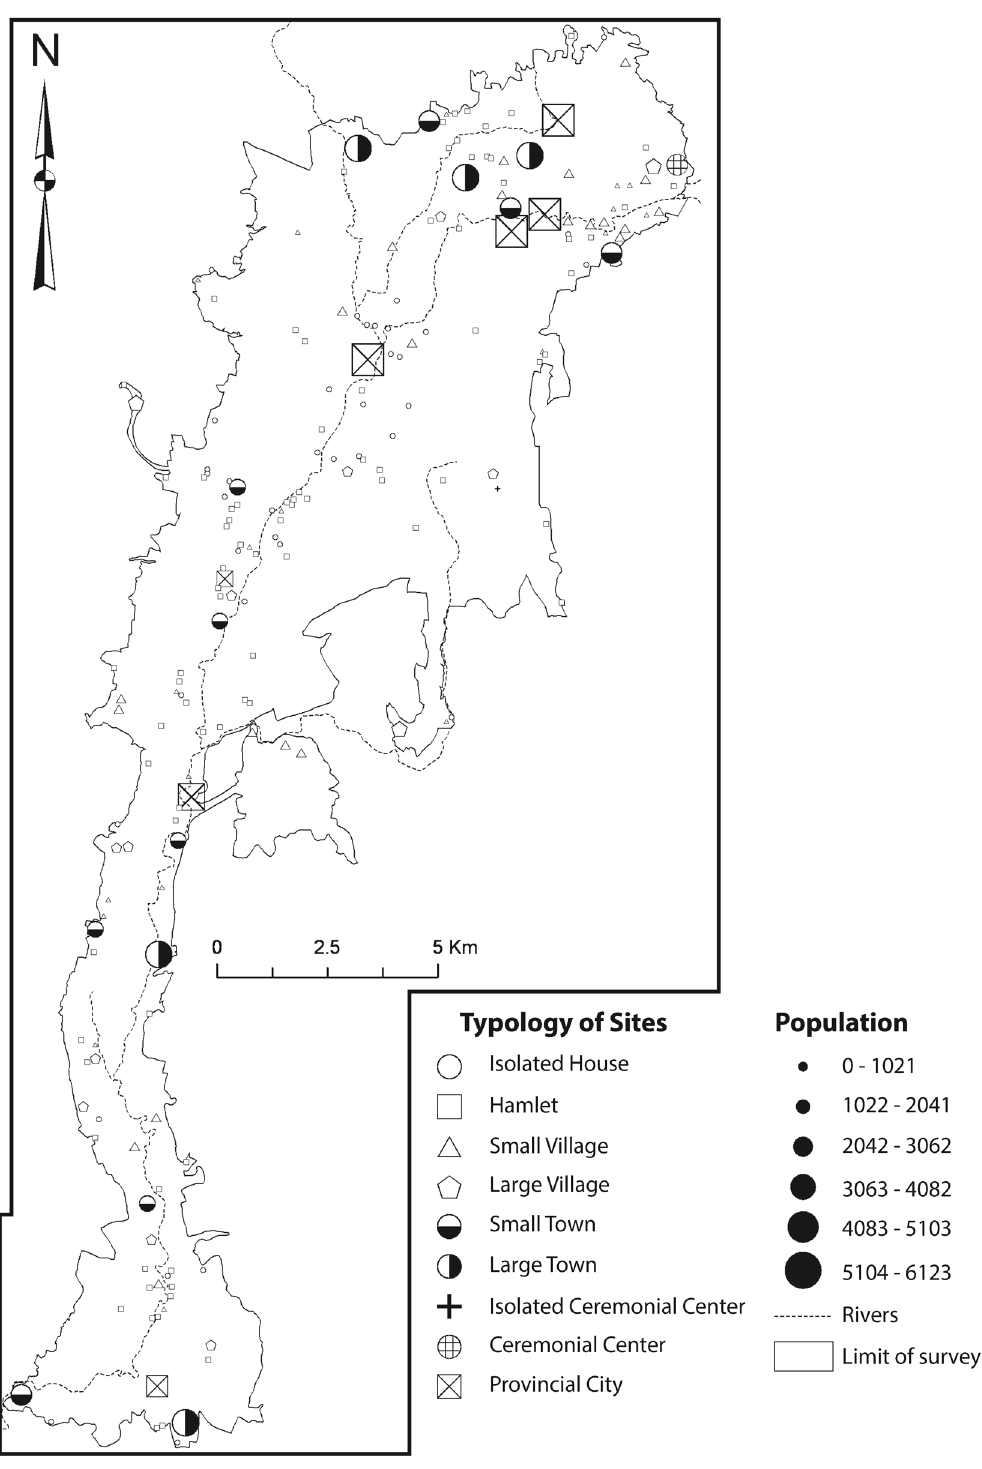
Figure 17: Settlement patterns of the Molotla ( Late Postclassic, B )